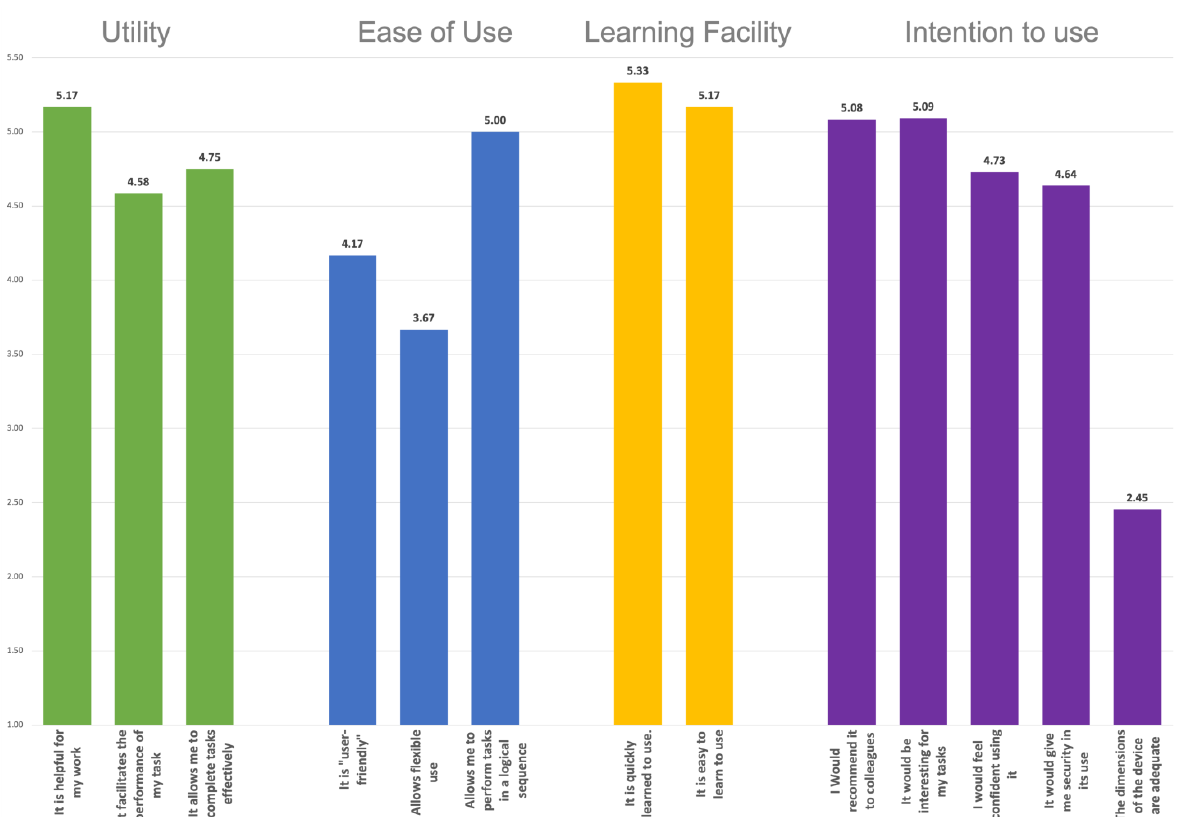
Figure 3. Professional usability questionaire.